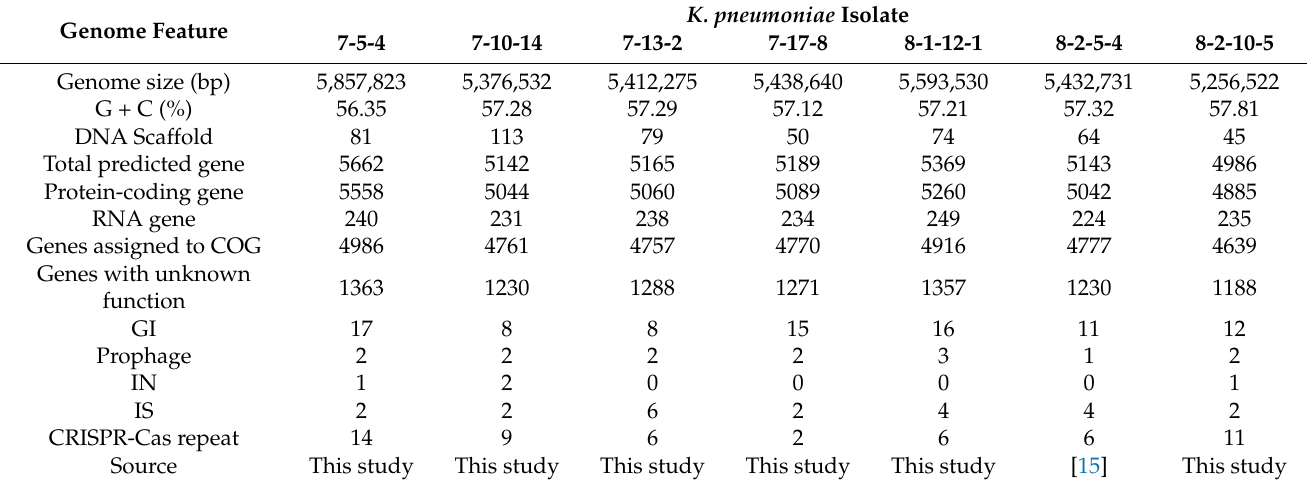
Table 1. Genome features of the K. pneumoniae isolates of aquatic animal